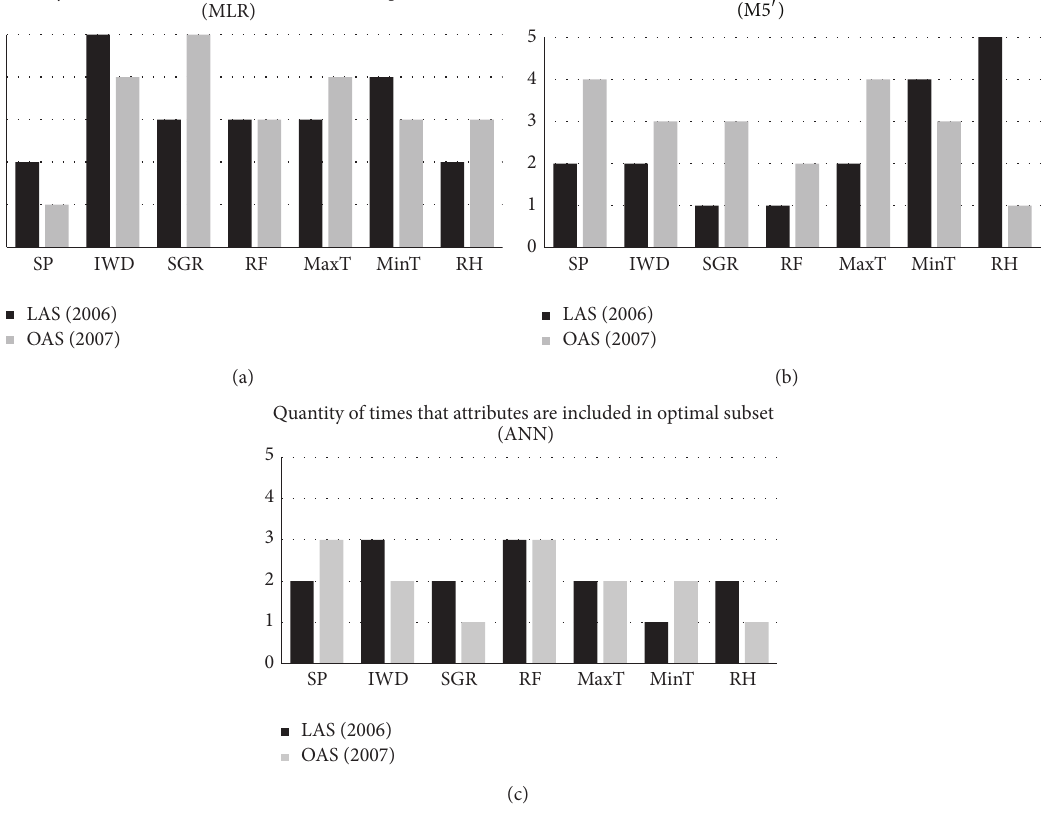
Figure 2: Quantity of occurrences of each attribute on the LAS and OAS for each technique (only crop datasets with 2007 testing data).